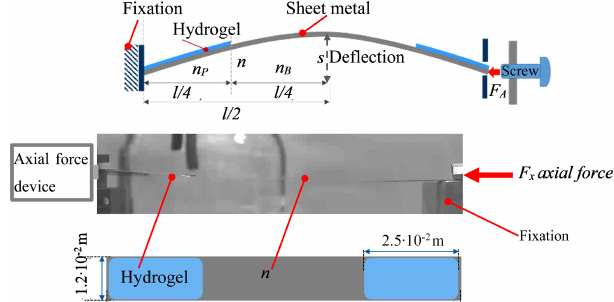
Figure 6. Deflection of the bending beam with structured hydrogel as function of the relative humidity. The resulting switching hys- teresis shows two switching points at 53%RH and